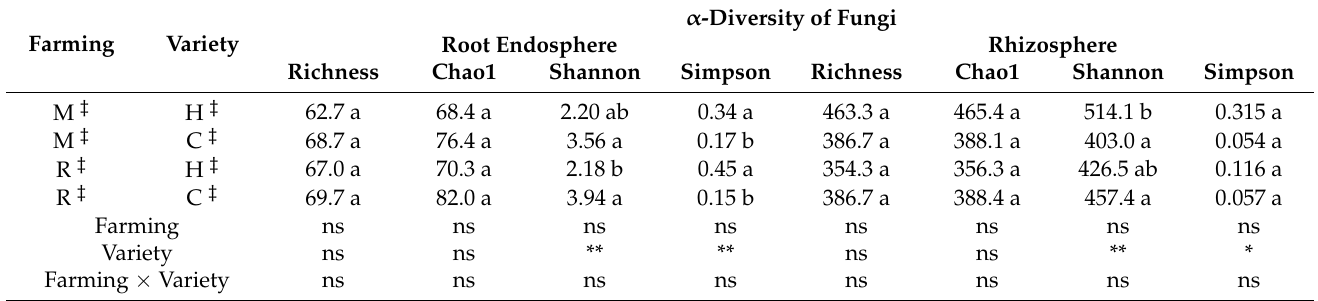
Table 2. The α -diversity of fungi in the root endosphere and rhizosphere in different varieties under different farming